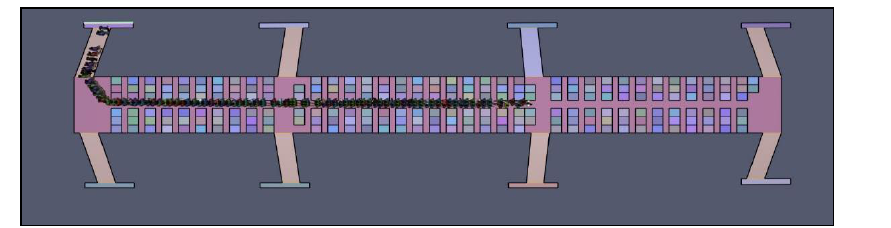
Figure 6 – Simulation moment for the seventh case of the second scenario after 130 seconds after the start of the simulation